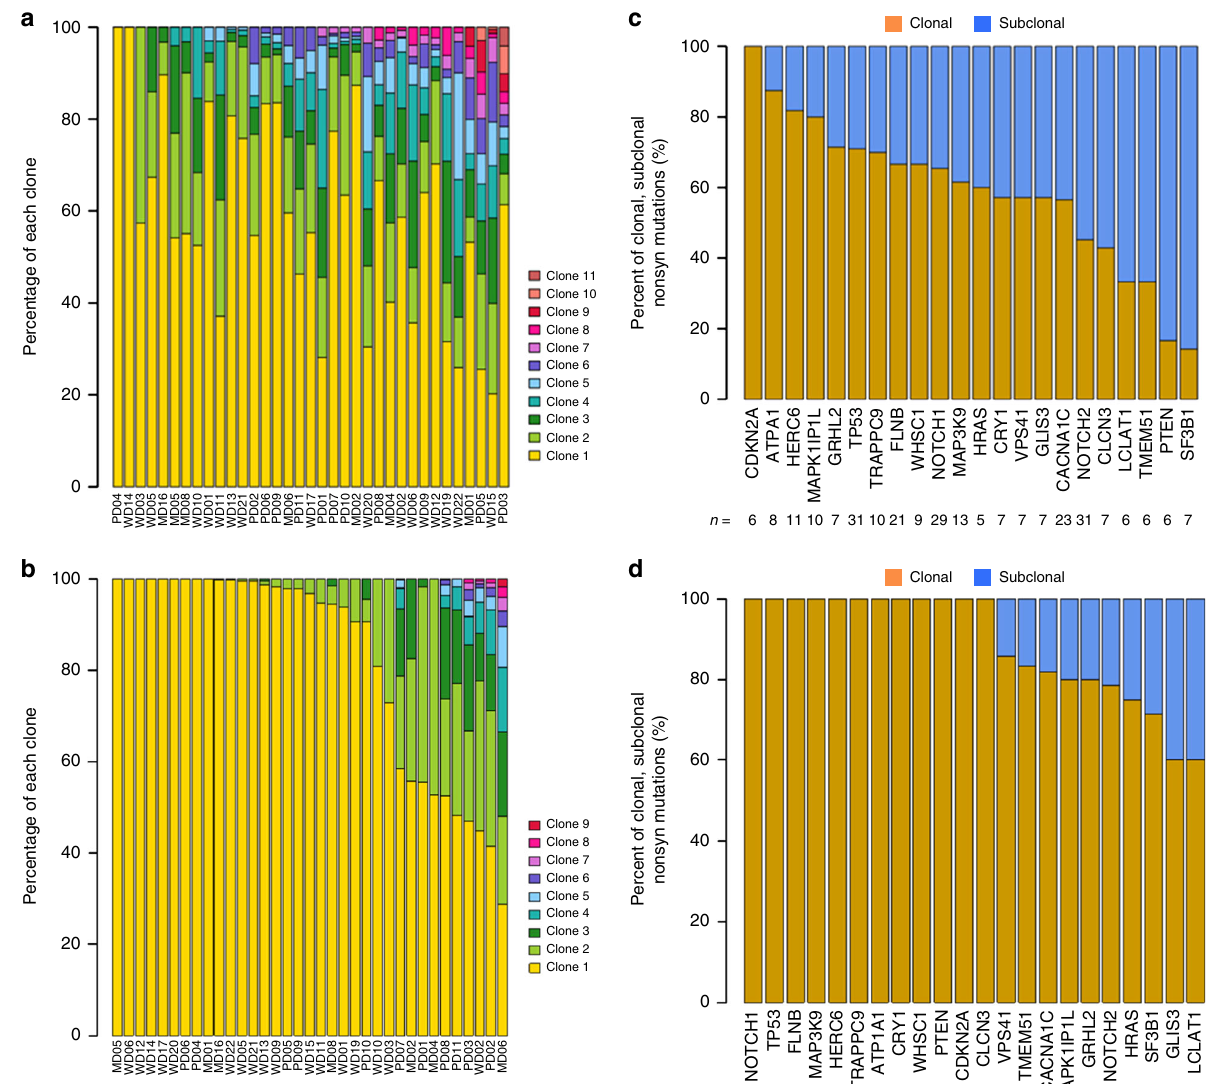
Fig. 4 Clonality analysis of cSCC tumour samples. Clonality analysis of 35 cSCC exomes using EXPANDS ( a ) and SciClone ( b ). Clonality analysis of 22 SMGs identifying clonal and subclonal nonsynonymous mutations using EXPANDS ( c ) and SciClone ( d ). The number of nonsynonymous mutations in each gene was also shown Identi fi cation of WD and MD/PD group-speci fi c SMGs . Dif- normal skin in at least 3 out of 5 data sets (Fig. 5b) suggesting respective potential tumour suppressing and tumour promoting roles in cSCC development. Within the ampli fi ed regions identi fi ed by GISTIC analysis, the mRNA levels of 23 genes were upregulated in cSCC compared to normal skin in GSE42677 (Fig. 6a), 38 in Data Set 1, 78 in GSE32628, 7 in GSE2503 and 43 in GSE84293 (Fig. 6b, top Venn diagram). Overlap analysis revealed that 19 genes were encoded in ampli fi ed regions and upregulated at the mRNA level in at least three of these data sets (Fig. 6b, c) indicating that these genes may play tumour promoting roles in cSCC. Nine genes within deleted regions identi fi ed by GISTIC analysis were also downregulated at the mRNA level in cSCC compared to normal skin in GSE42677 (Fig. 6a), 11 in Data set 1, 24 in GSE3268,, 2 in GSE2503 and 5 in GSE84293 (Fig. 6b, bottom Venn diagram). Overlap analysis revealed that fi ve genes were encoded in deleted regions and downregulated at the mRNA level in at least three of these data sets (Fig. 6b, c) indicating that these genes may play tumour suppressor roles in cSCC. NATURE COMMUNICATIONS| (2018) 9:3667 |DOI: